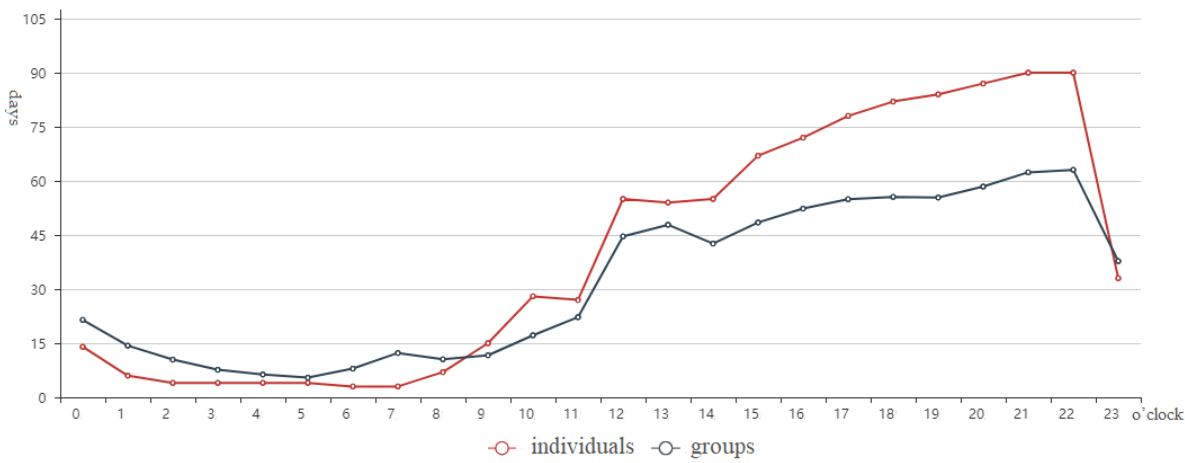
Figure 3. Comparison of time preference between individuals and groups.